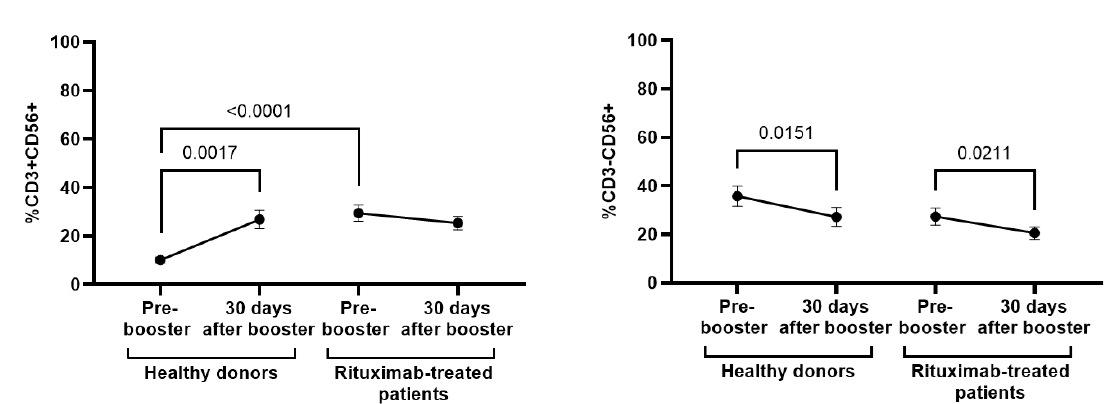
Figure 3. Analysis of ADCC response of PBMCs from rituximab-treated patients and healthy donors before and after receiving the booster dose of COVID-19 vaccine. ( A ) Quantification of the expression of phosphatidylserine in the surface of rituximab-coated Raji cells cocultured with PBMCs isolated from rituximab-treated patients and healthy donors before and after receiving the booster dose, after staining with Annexin V. ( B ) Total levels of CD3+ T cells in individuals of both cohorts that were present in the supernatant of the coculture. ( C ) Levels of CD3+CD8 − TCR γδ + subpopulation (left graph) and CD3+CD8+TCR γδ + subpopulation (right graph) in PBMCs from individuals of both cohorts. ( D ) Levels of NKT-like cells (CD3+CD56+) (left graph) and NK cells (CD3-CD56+) (right graph) in PBMCs from individuals of both cohorts. Each dot in the graphs corresponds to the mean ± SEM. Statistical significance between groups was calculated using the Mann–Whitney test, and statistical significance within groups was calculated using the Wilcoxon signed-rank test.